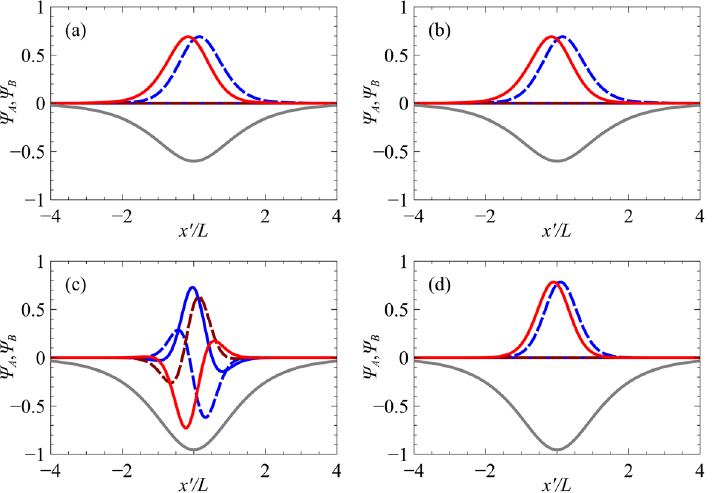
Figure 3. The normalized zero-energy state (lowest positive momentum) wavefunctions of the hyperbolic 3.2 and orientation: ( a ) θ 0 and ( c ) θ π/ 2 V 0 / cosh ( x ′ / L ) , of strength V 0 secant potential, V ( x ′ ) = − = = − = 0.86 v F , v 0.32 v F , for the s 1 0.69 v F and v in a tilted Dirac material defined by parameters v x t = y = = = chirality, i.e., the K valley in the effective graphene sheet. The corresponding wavefunctions of the effective graphene waveguide are given in panels ( b ) and ( d ). The solid red and blue lines correspond to the real part of ψ A and ψ B respectively, while the dashed lines correspond to their imaginary parts. The grey line shows the potential as a guide to the